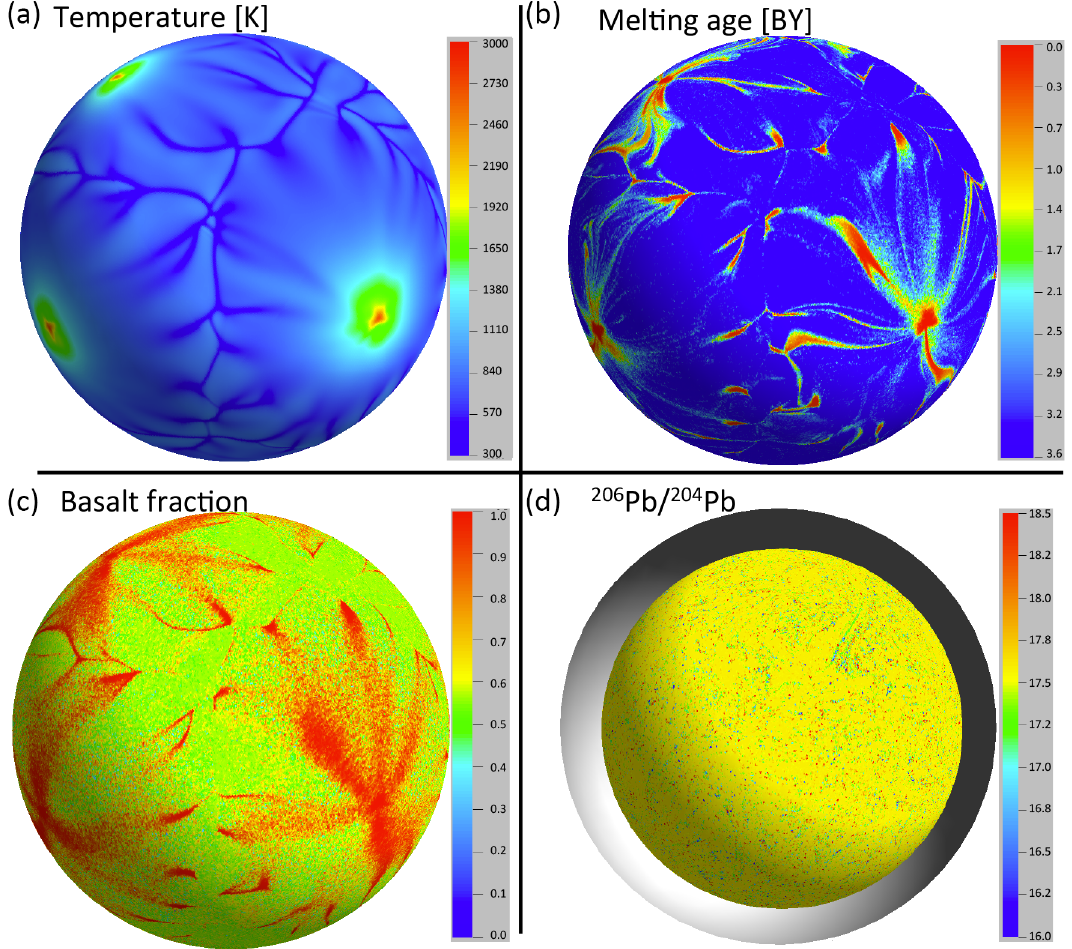
Figure 4. Snapshots taken at the end of the calculation of (a) temperature 50km below the surface; (b) time since melting (in billions of years) 50km below the surface; (c) basalt fraction at the surface; (d) 206 Pb / 204 Pb molar ratio at a depth of 1300km. Note that melting in our model happens at the top of regions of central upwellings (plumes). Also, as the lead isotope panel (d) shows, the mid-mantle seems to be fairly homogenous on the scale modelled here. For the melting time (b) , basalt fraction (c) and lead isotope ratio (d) the values were linearly interpolated from the particles to the grid before